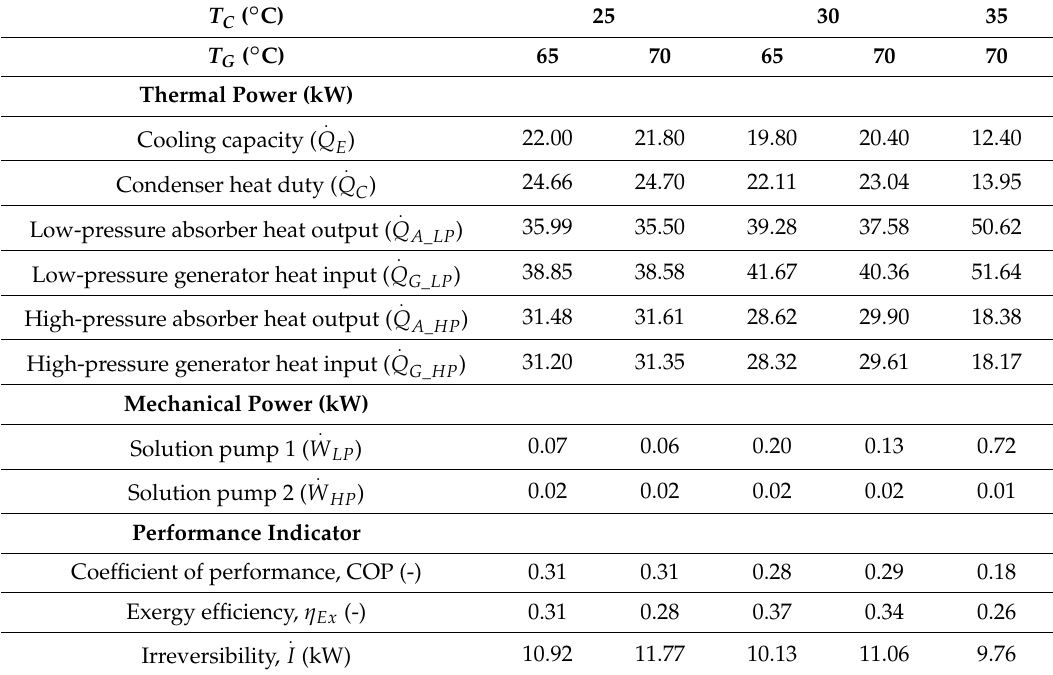
Table 5. Performance summary of the modeling of well W-LV5 coupled to a half-effect cooling system. Case study: Refrigeration ( T E = − 6, PF = 0.7).